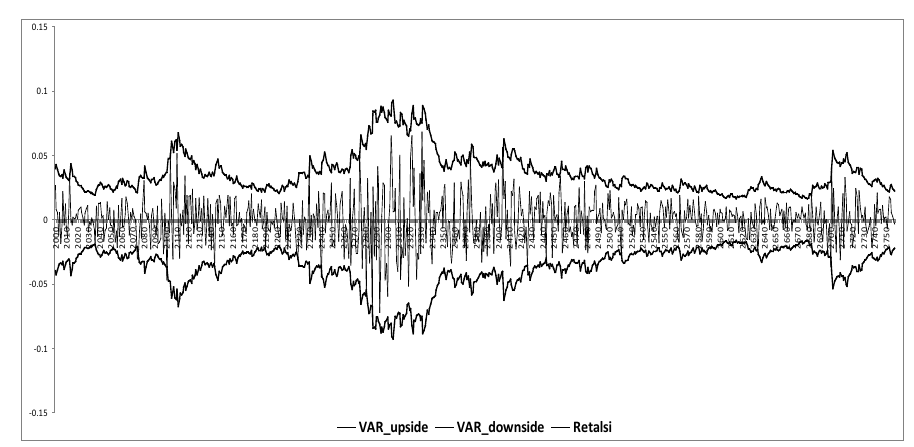
FIGURE 1: Garch-N Source: Authors’ calculations, based on JSE ALSI return series